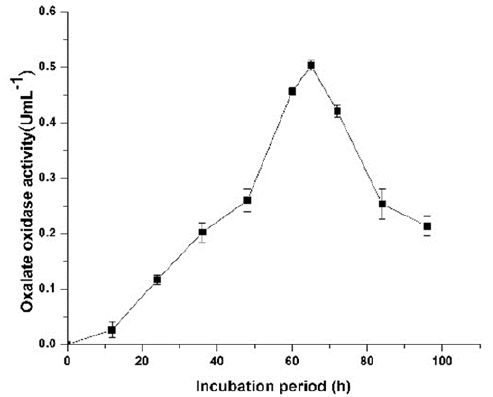
Fig. 4. Time course study of oxalate oxidase production in optimized medium and conditions. Medium having 20 gL -1 of sucrose, 5 gL -1 sodium oxalate and 2 gL -1 NH Cl, 0.05 gL -1 MnSO along with basal salts was used. 4 4 Experiments were conducted at 30°C, fill up volume of one-tenth, agitation rate of 200 rpm and initial medium pH of 6.5 with inoculum age of 18